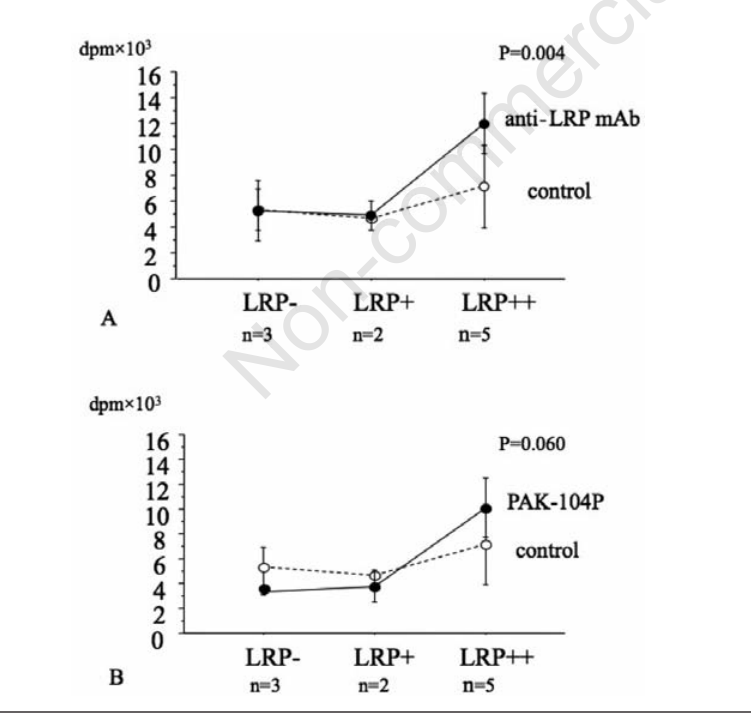
Figure 1. DNR accumulation in isolated nuclei and effects of the addition of (A) anti- LRP mAb and (B) PAK-104P. A) DNR accumulation with the addition of anti-LRP mAb increased significantly when the leukemic blast cells were LRP++ (P=0.004); B) PAK- 104P increased DNR accumulation when the samples were LRP++, with marginal signif- icance (P=0.06). Open circles ( ° ) indicate the untreated controls; closed circles ( l ) indi- cate the presence of anti-LRP mAb or PAK-104P. Data are expressed as the mean±SD of triplicate results.